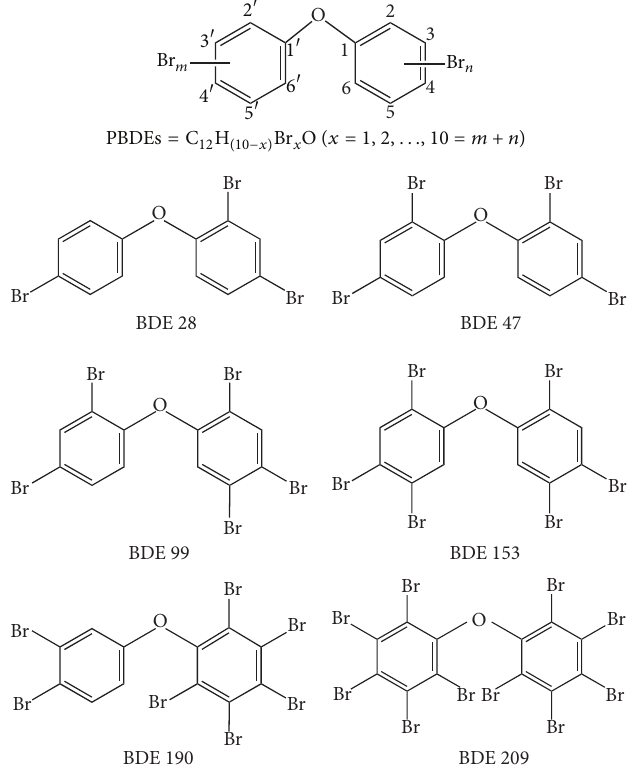
Figure 1: The chemical structures of six major PBDEs including BDE 28, BDE 47, BDE 99, BDE 153, BDE 190, and BDE 209.